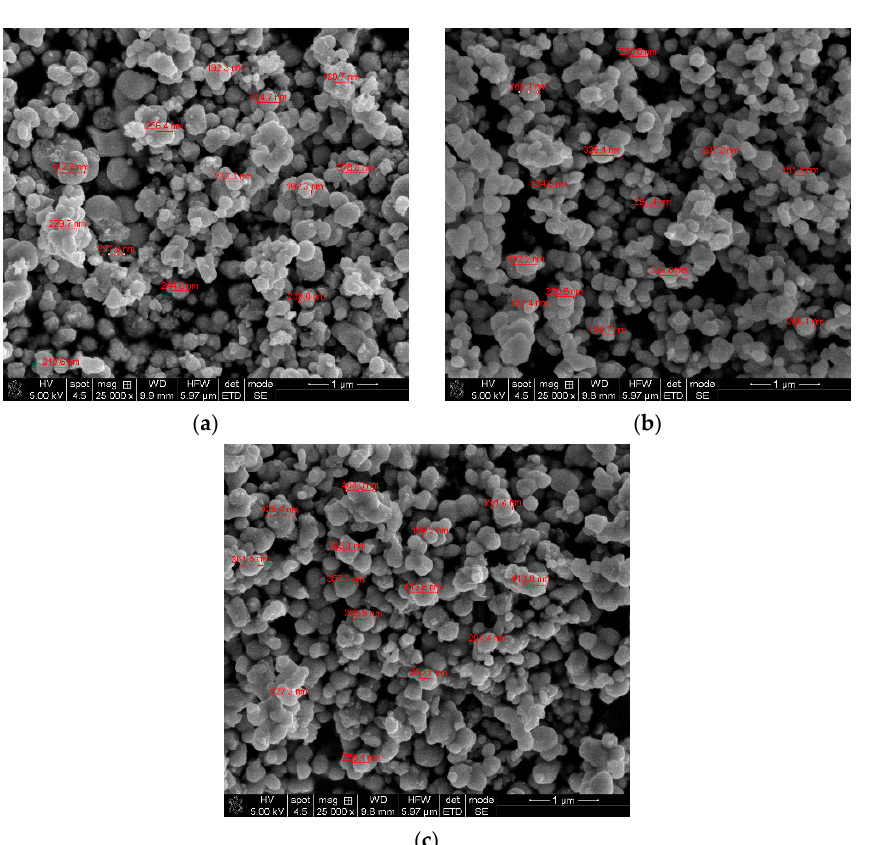
Figure 7. SEM micrographs of the thermally treated samples; ( a ) TiO 2 MW, ( b ) TiO 2 − Cu 2.0% MW, ( c ) TiO 2 − Zn 2.0%